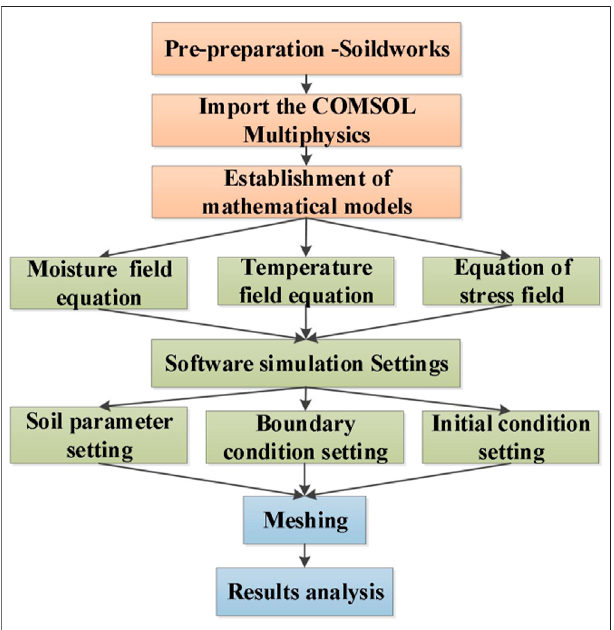
FIGURE 4 | The simulation